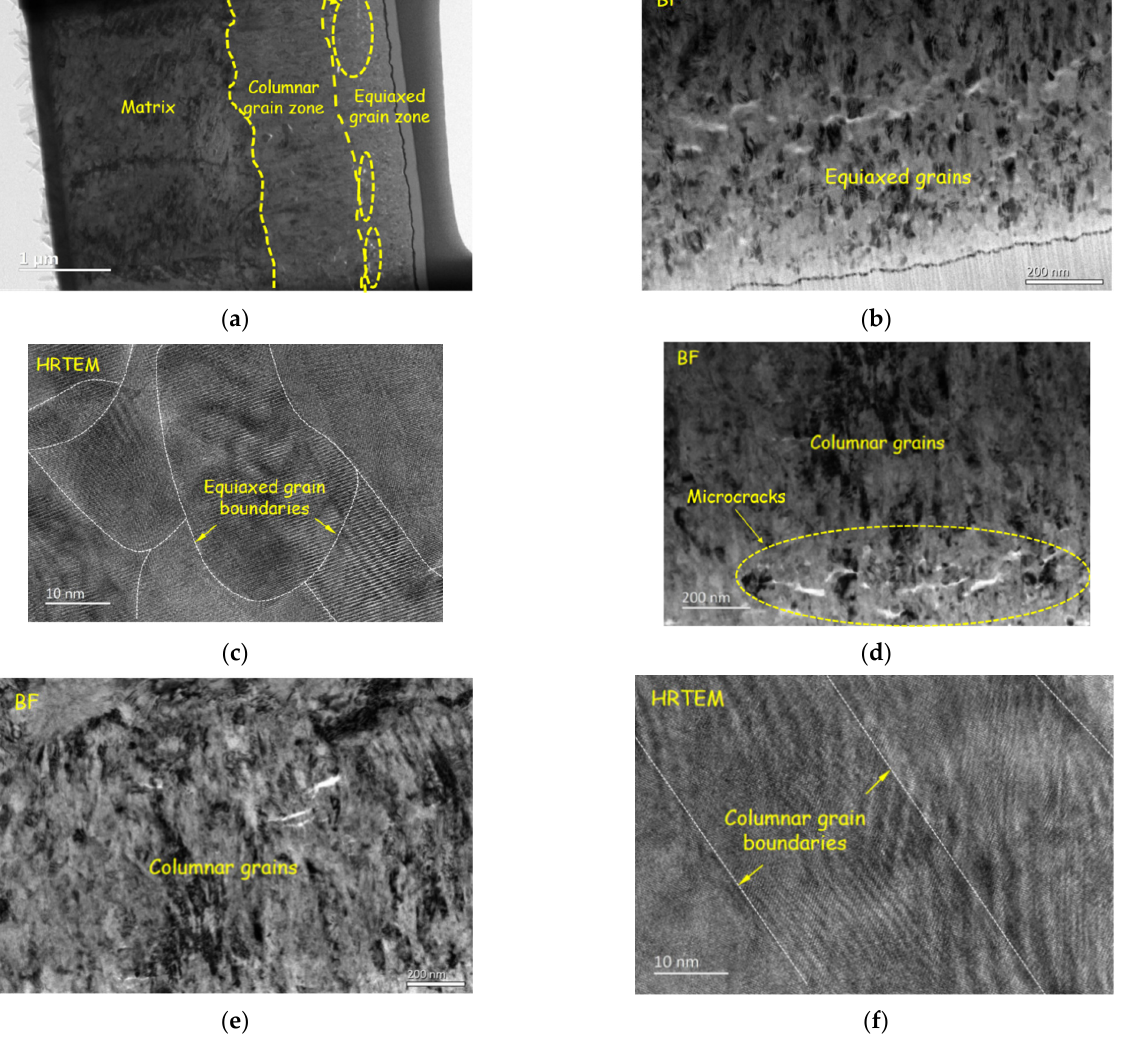
Figure 8. Oxide morphology of original plates corroded for 100 days: ( a ) overall morphology; ( b ) TEM image of equiaxed grains zone; ( c ) HRTEM image of equiaxed grains zone; ( d ) TEM image of columnar grains zone, with some microcracks; ( e ) TEM image of columnar grains zone; and ( f ) HRTEM image of columnar grains zone.